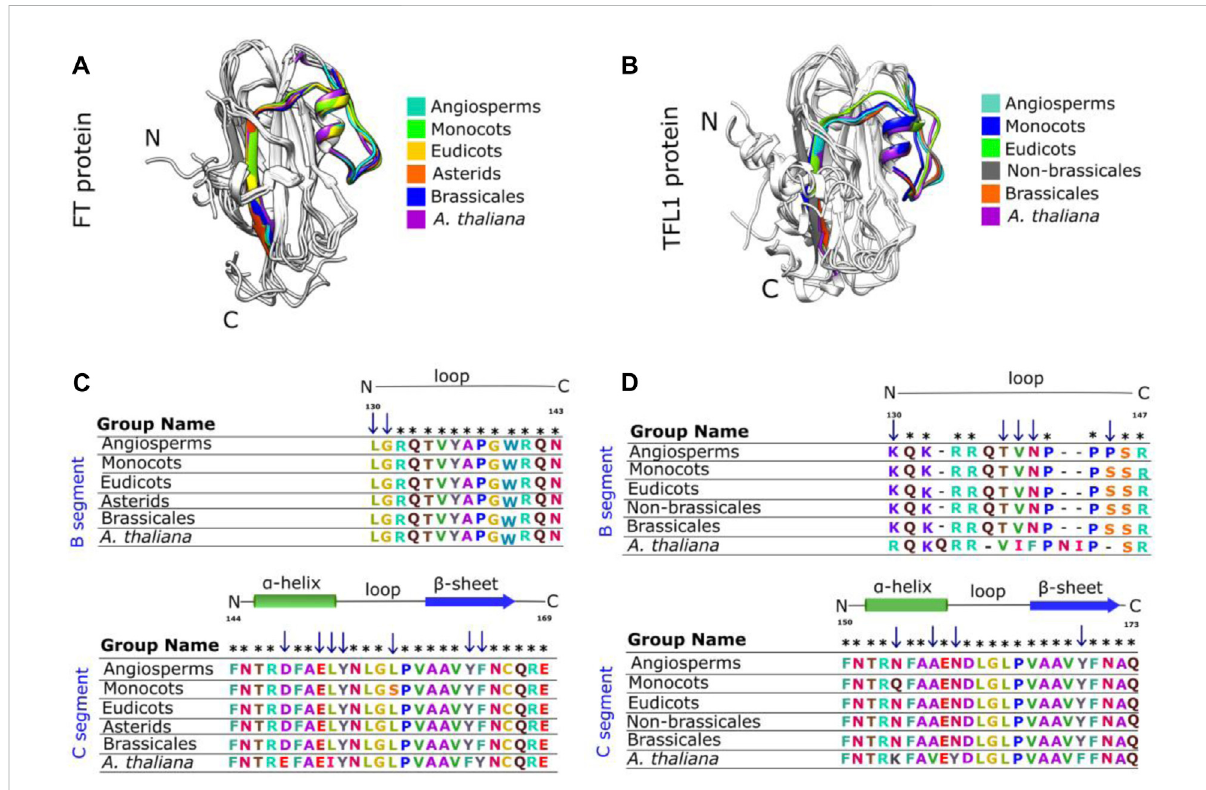
FIGURE 5 The segment C of FT and TFL1 protein structures are conserved across extant and reconstructed ancestral sequences even with amino acid substitutions. Structural alignment of the segments C from the ancestral FT (A) and TFL1 (B) sequences, which are coded by the fourth exon. Sequence alignment of the FT (C) and TFL1 (D) ancestors. Asterisks indicate matches in the alignment sequences, and the blue arrows indicate the residues